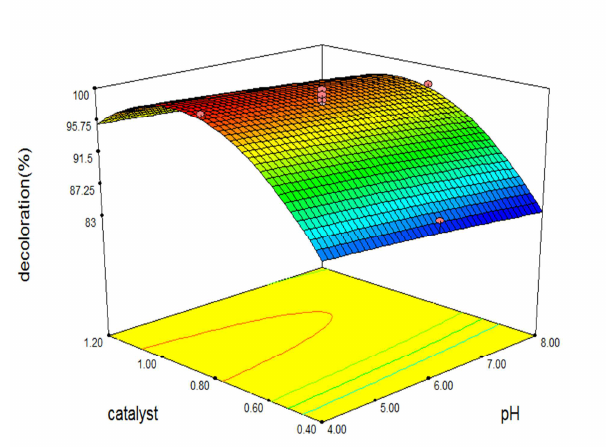
Figure 7. The effect of initial nanoparticles dose (copper oxide doped zinc oxide) and pH on degreadation of acid black